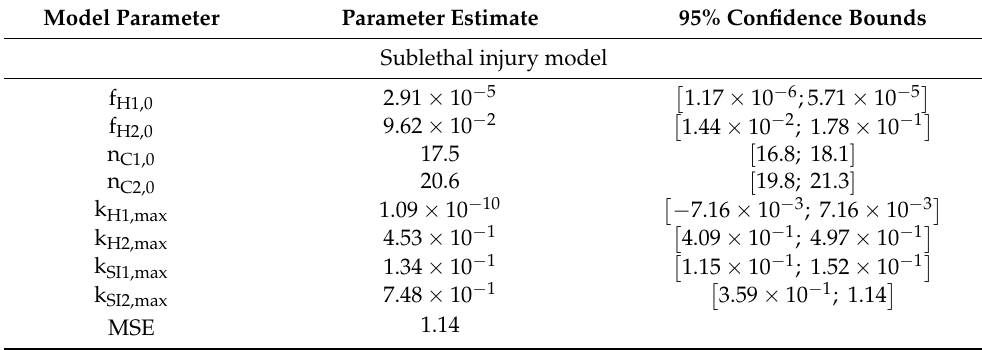
Table 2. Cont. Model